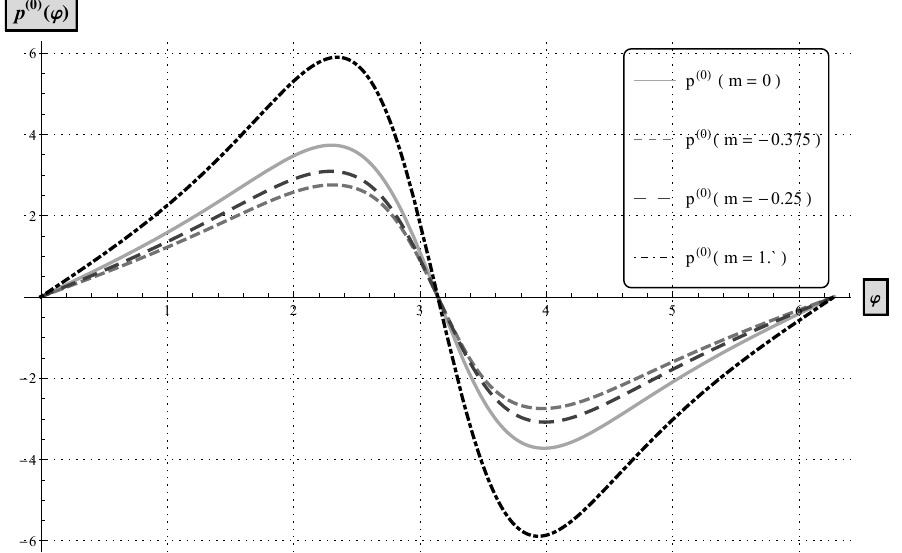
Figure 8. Pressure distributions computed from the classical Reynolds equation, p ( 0 ) ( θ ) ( m = 0 ) , and from the power-law system of Reynolds type equations, p ( 0 ) ( θ ) ( m = − 0.375, − 0.25, 1 ) , with χ = 0.5.